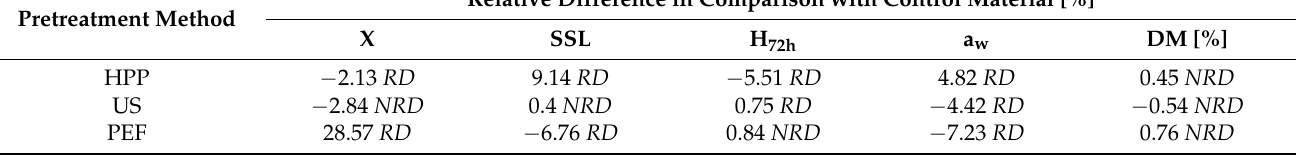
Table 2. Relative values of water activity, dry matter content, rehydration and hygroscopic properties of dried apples pretreated with different methods, calculated in reference to control (untreated, dried) material. Relative Difference in Comparison with Control Material [%] Pretreatment Method X SSL H